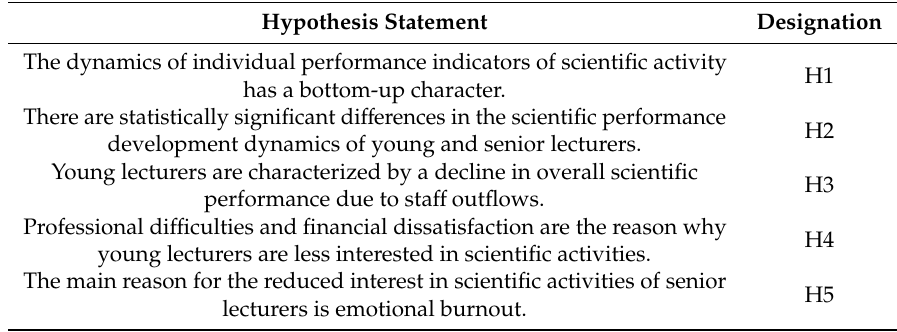
Table 1. The paper’s